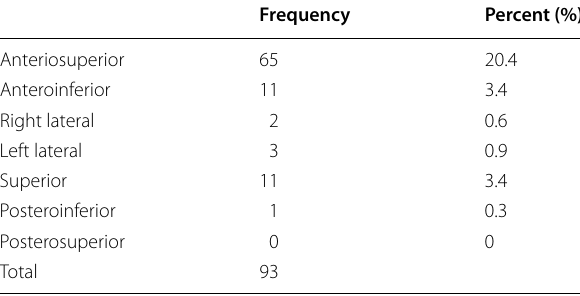
Table 2 Accessory appendage localization